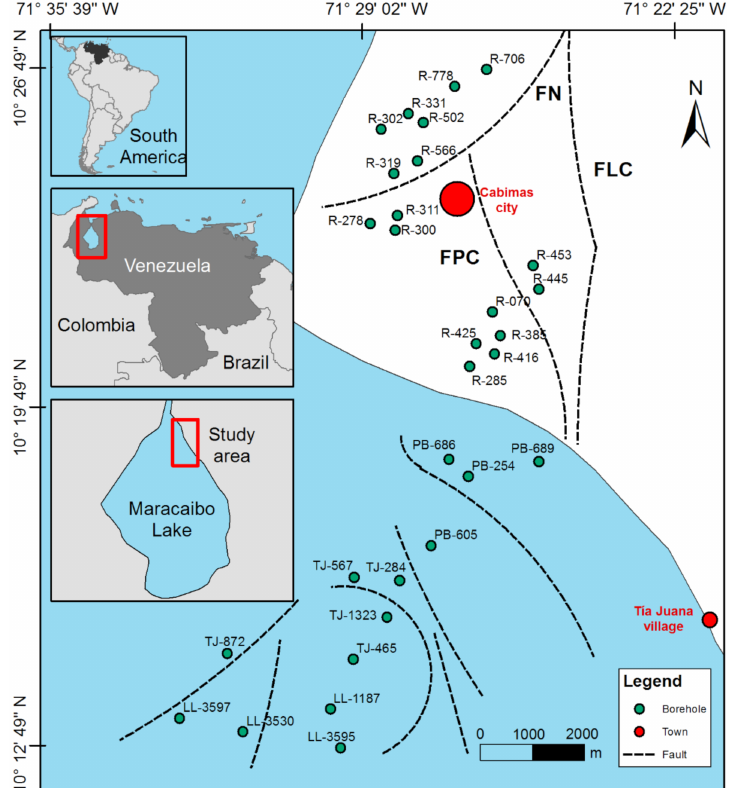
Figure 1. Northern Bolivar Coastal Complex map. It shows the location of the study oil